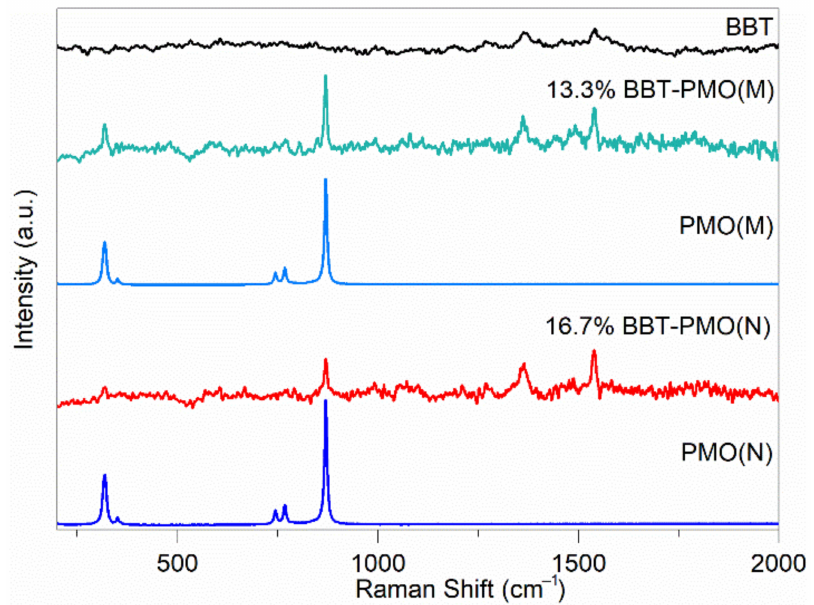
Figure 4. Raman spectra of BBT, 13.3% BBT-PMO(M) and PMO(M), and 16.7% BBT-PMO(N), and